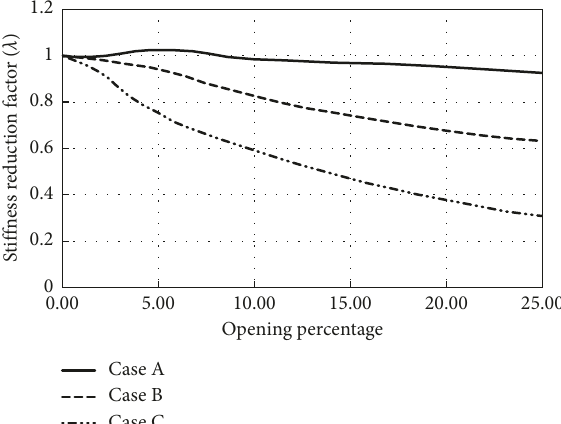
Figure 11: The relationship between the stiffness reduction factor and the opening